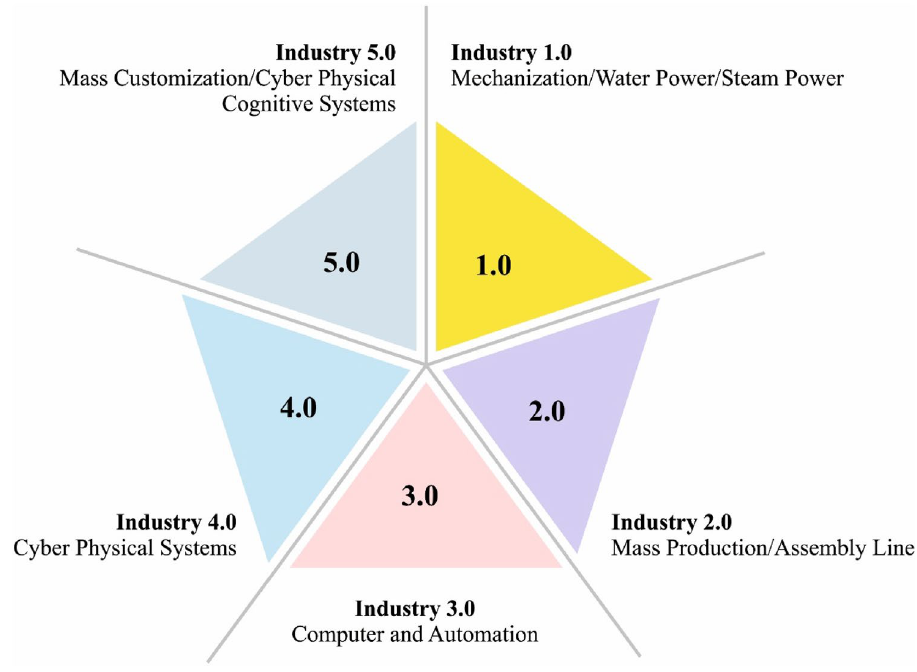
Figure 1. Evolution of CPS in Industry